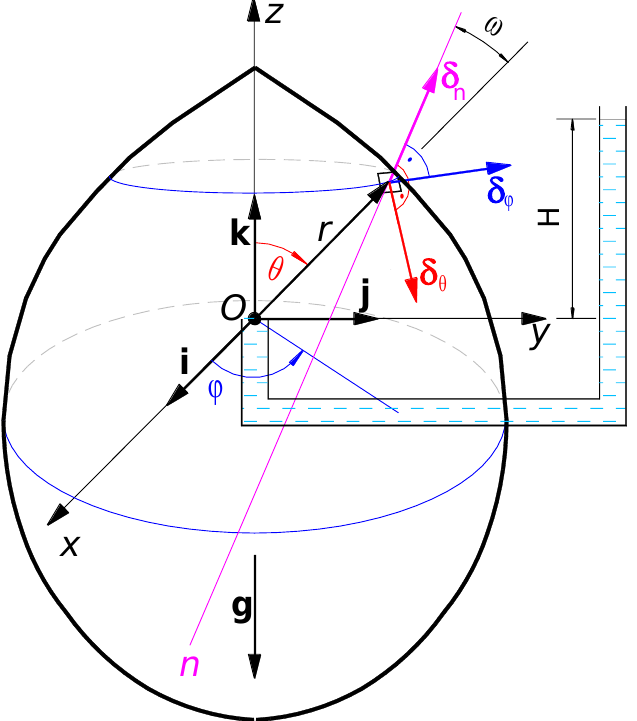
Figure 1. A shape of a drop with an infinitesimal surface area marked, the Cartesian coordinate system (x, y, z), and the surface coordinate system (θ, φ). Since hydrostatic pressure depends only on the z coordinate, or polar angle θ in the